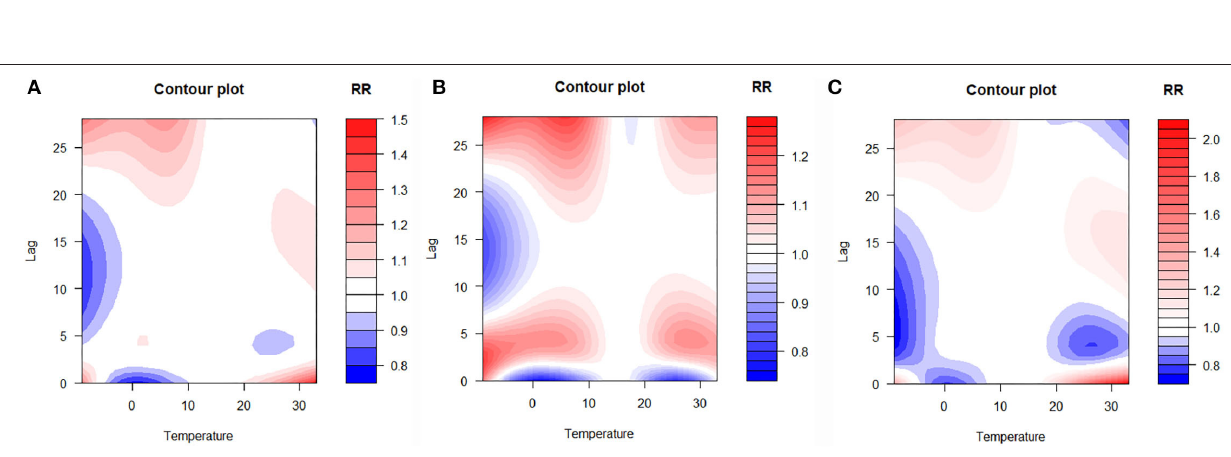
Frontiers in Medicine | www.frontiersin.org 4 July 2022 | Volume 9 | Article